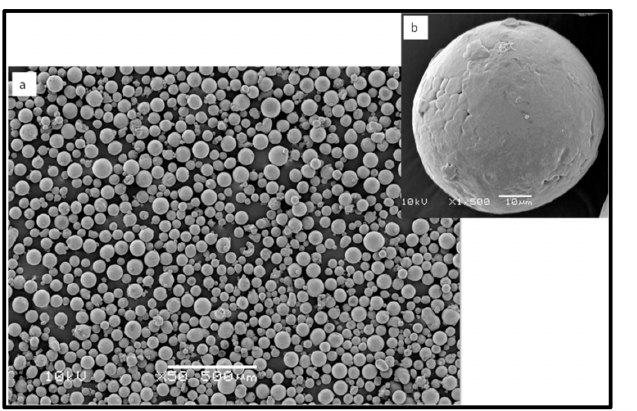
Figure 8. ( a ) SEM image of Ti-6Al-4V powder particles of different sizes and ( b ) an individual particle.